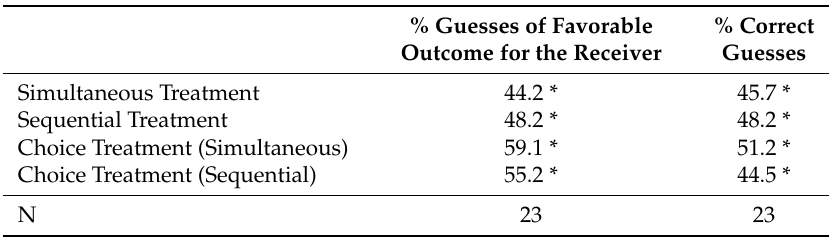
Table 7. Observer